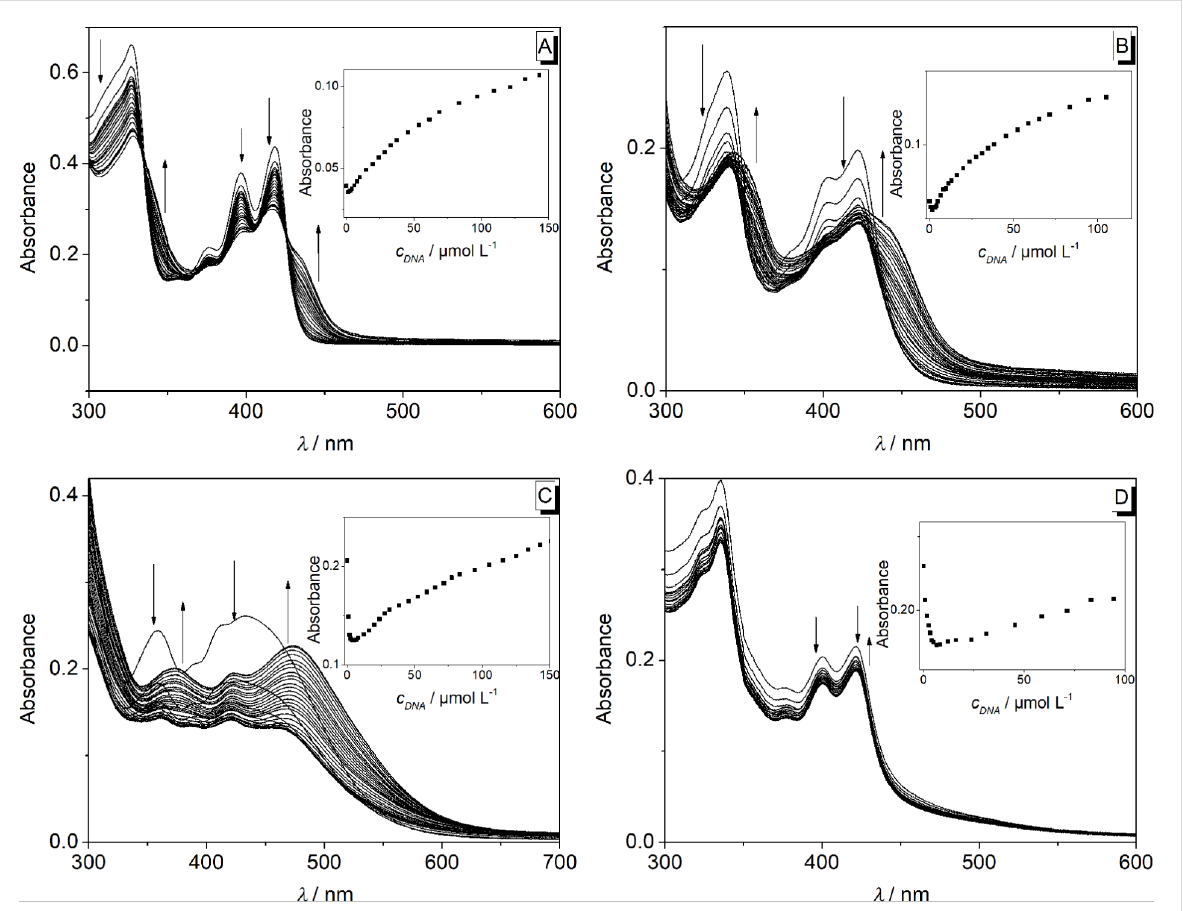
Figure 6: Photometric titration of 2a (A), 2b (B), 2c (C), and 2d (D) with ct DNA in BPE buffer (16 mM Na + ; 5% DMSO; pH 7.0); c L = 20.0 μ M. Arrows indicate the development of bands with increasing DNA concentration. Inset: Plot of the absorption at long wavelength versus DNA concentration.